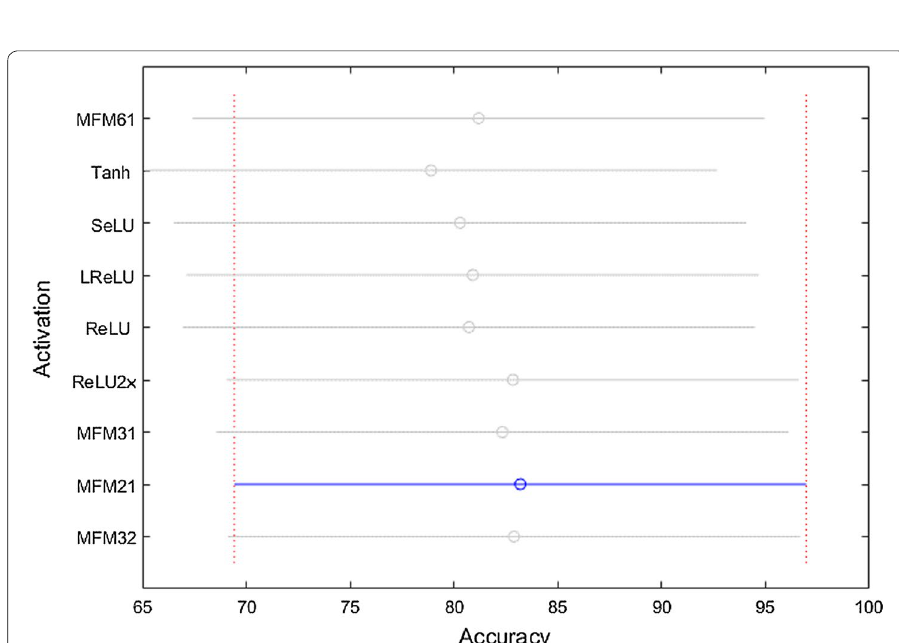
Fig. 14 Multiple comparisons, activations on sound